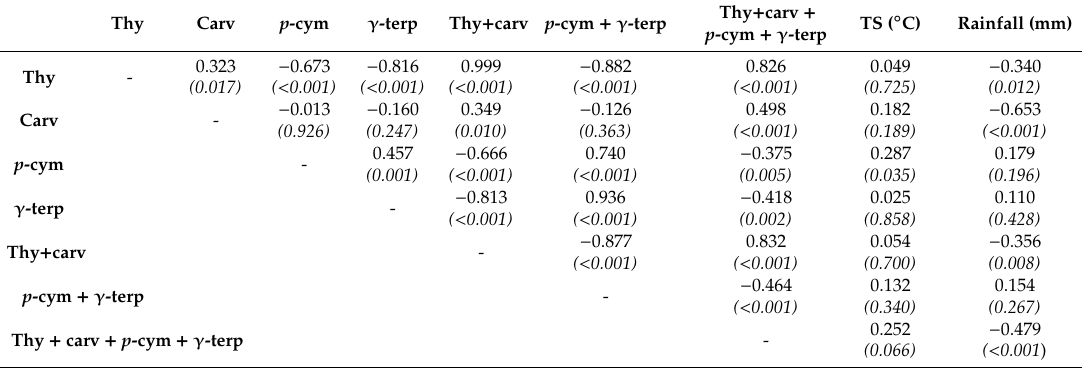
Table 4. Correlation coe ffi cients and p values (in Italic) among the major compounds of the EO of Origanum heracleoticum cultivated in a 3-year trial in 3 Sicilian localities; n = 54. Thy: thymol;